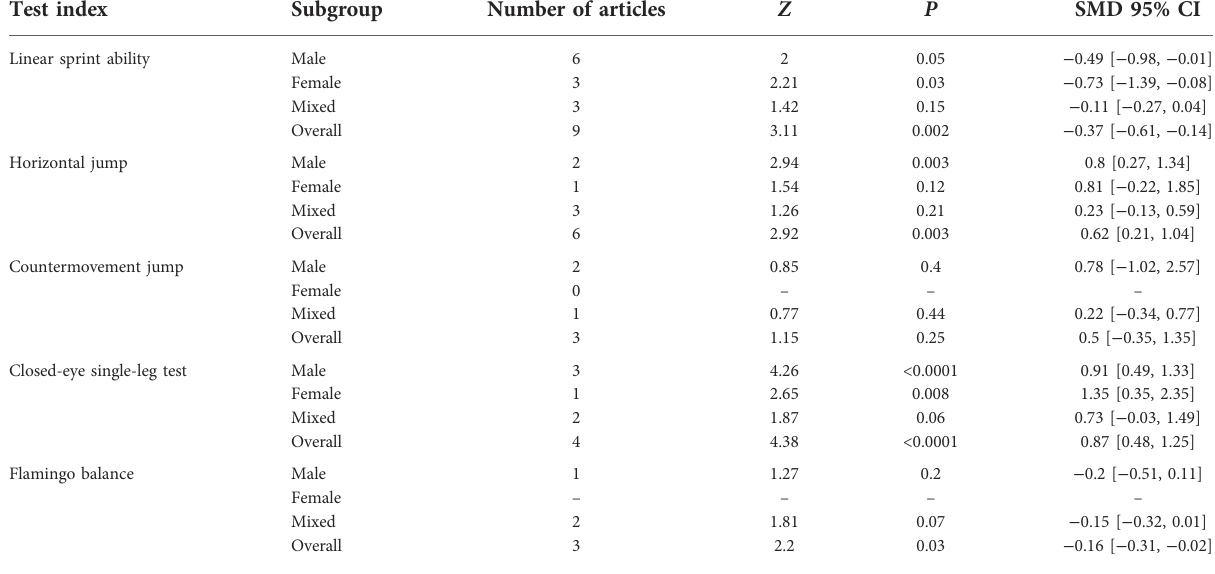
TABLE 5 Comparison of effects by